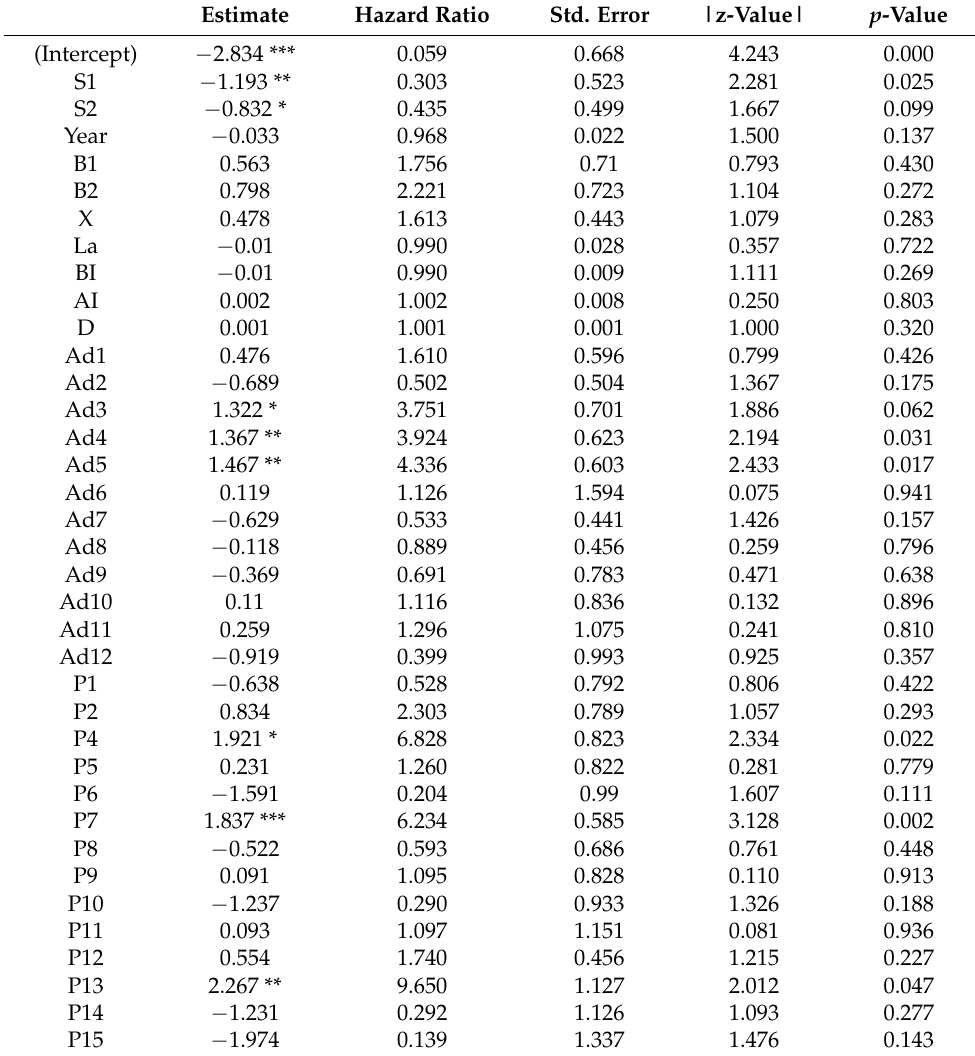
Table 4. Estimation results of the failure